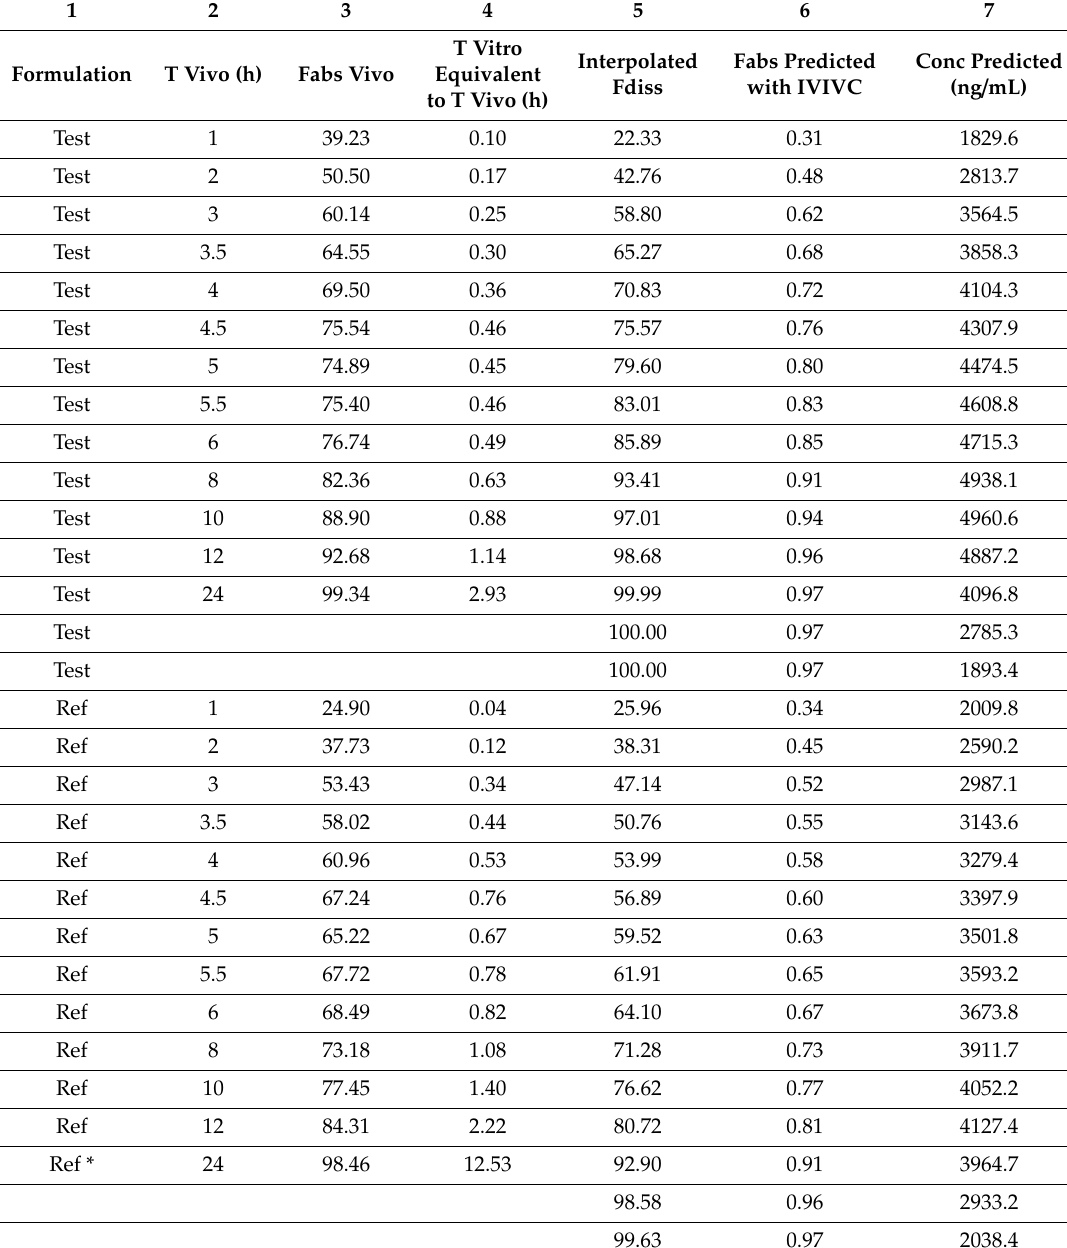
Table 3. Columns 1 to 4: Calculations for the Levy plot. Second and third column are the original in vivo data. Fourth column, “t vitro” are obtained from the Weibull function used to fit the in vitro profiles of each formulation using Equation (4) (see step 2 in Figure 1) and interpolation fraction absorbed values, i.e., in the in vitro dissolution profile it takes 0.1 h to get 39.23% dissolved. Column 5 fractions dissolved estimated at the original in vivo sampling times. Column 3 and 5 were used to represent the IVIVC. Columns 6 and 7 predicted fractions absorbed from the IVIVC linear relationship and the back-calculated predicted plasma